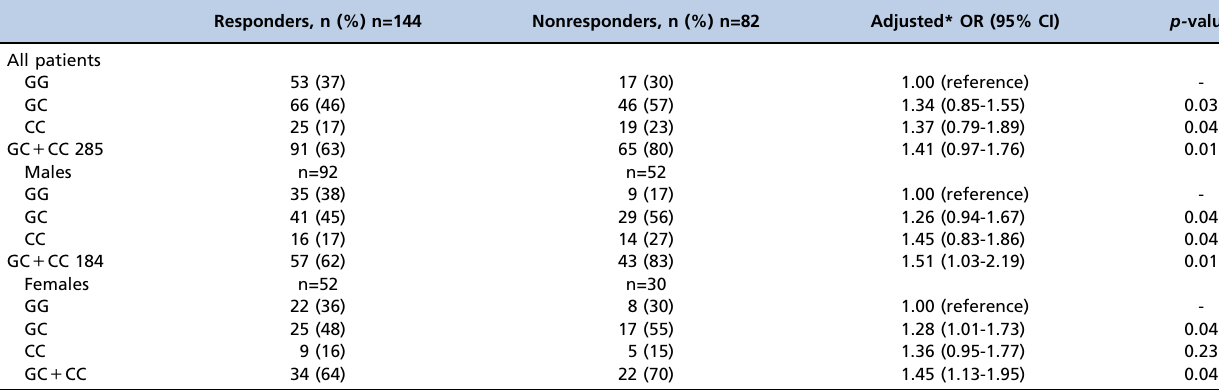
Table 4 - Association of the Asp1104His polymorphism of ERCC5 with treatment sensitivity to oxaliplatin. Responders, n (%) n=144 Nonresponders, n (%) n=82 Adjusted* OR (95% CI) p- value All patients GG 53